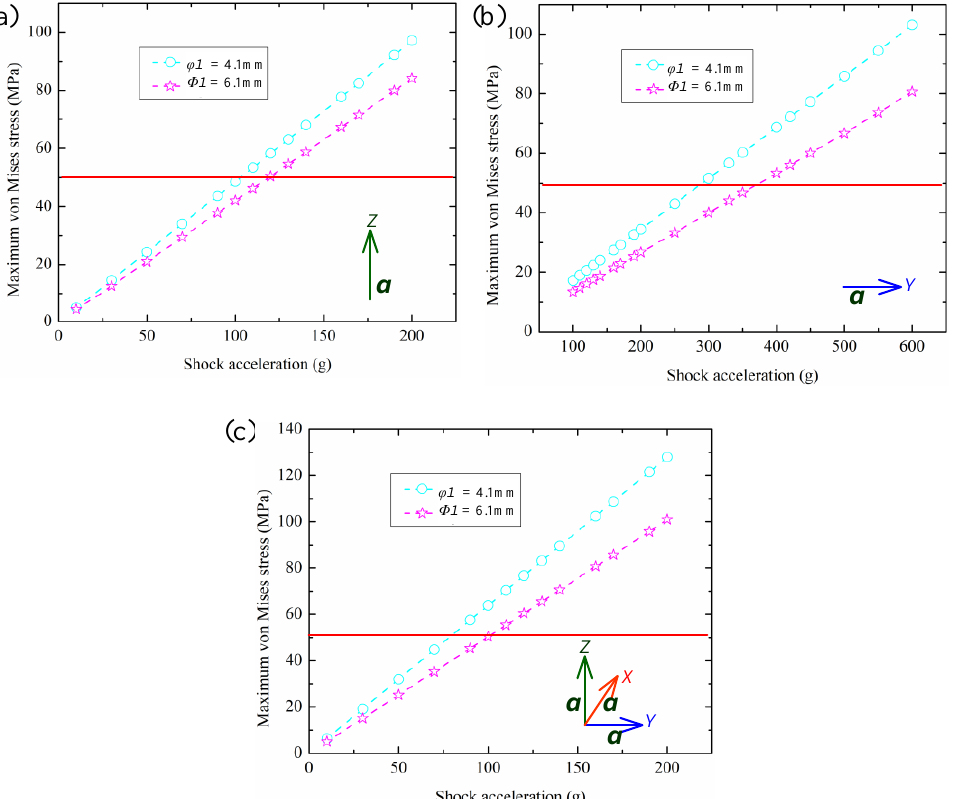
Figure 4. Variation of σ von-Mises as a function of the shock acceleration and the diameter φ1 of the holes used to fix the cavity (Figure 1) as well as a loading along the three directions: ( a ) Vertical direction ( Z -axis). ( b ) Horizontal direction ( Y -axis). ( c ) Three orthogonal directions ( X -axis, Y -axis, and Z -axis). The cyan dashed line with circles and the magenta dashed line with stars represent σ von-Mises corresponding to diameters of 4.1 mm and 6.1 mm, respectively. The red line represents the ultimate tensile stress σ max of the material ULE of the USOC.